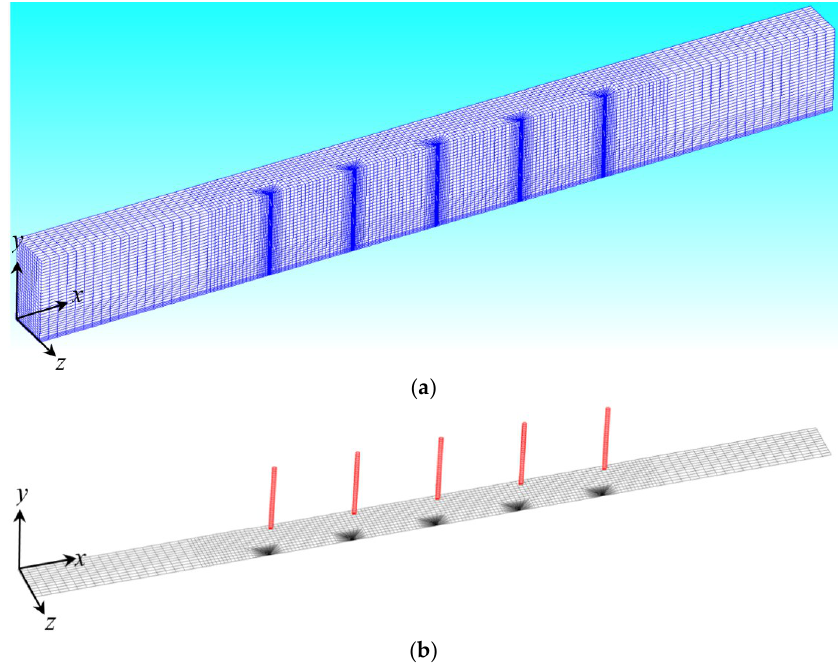
Figure 3. Computational grid system. ( a ) The entire computational domain; ( b ) The electrode grid.